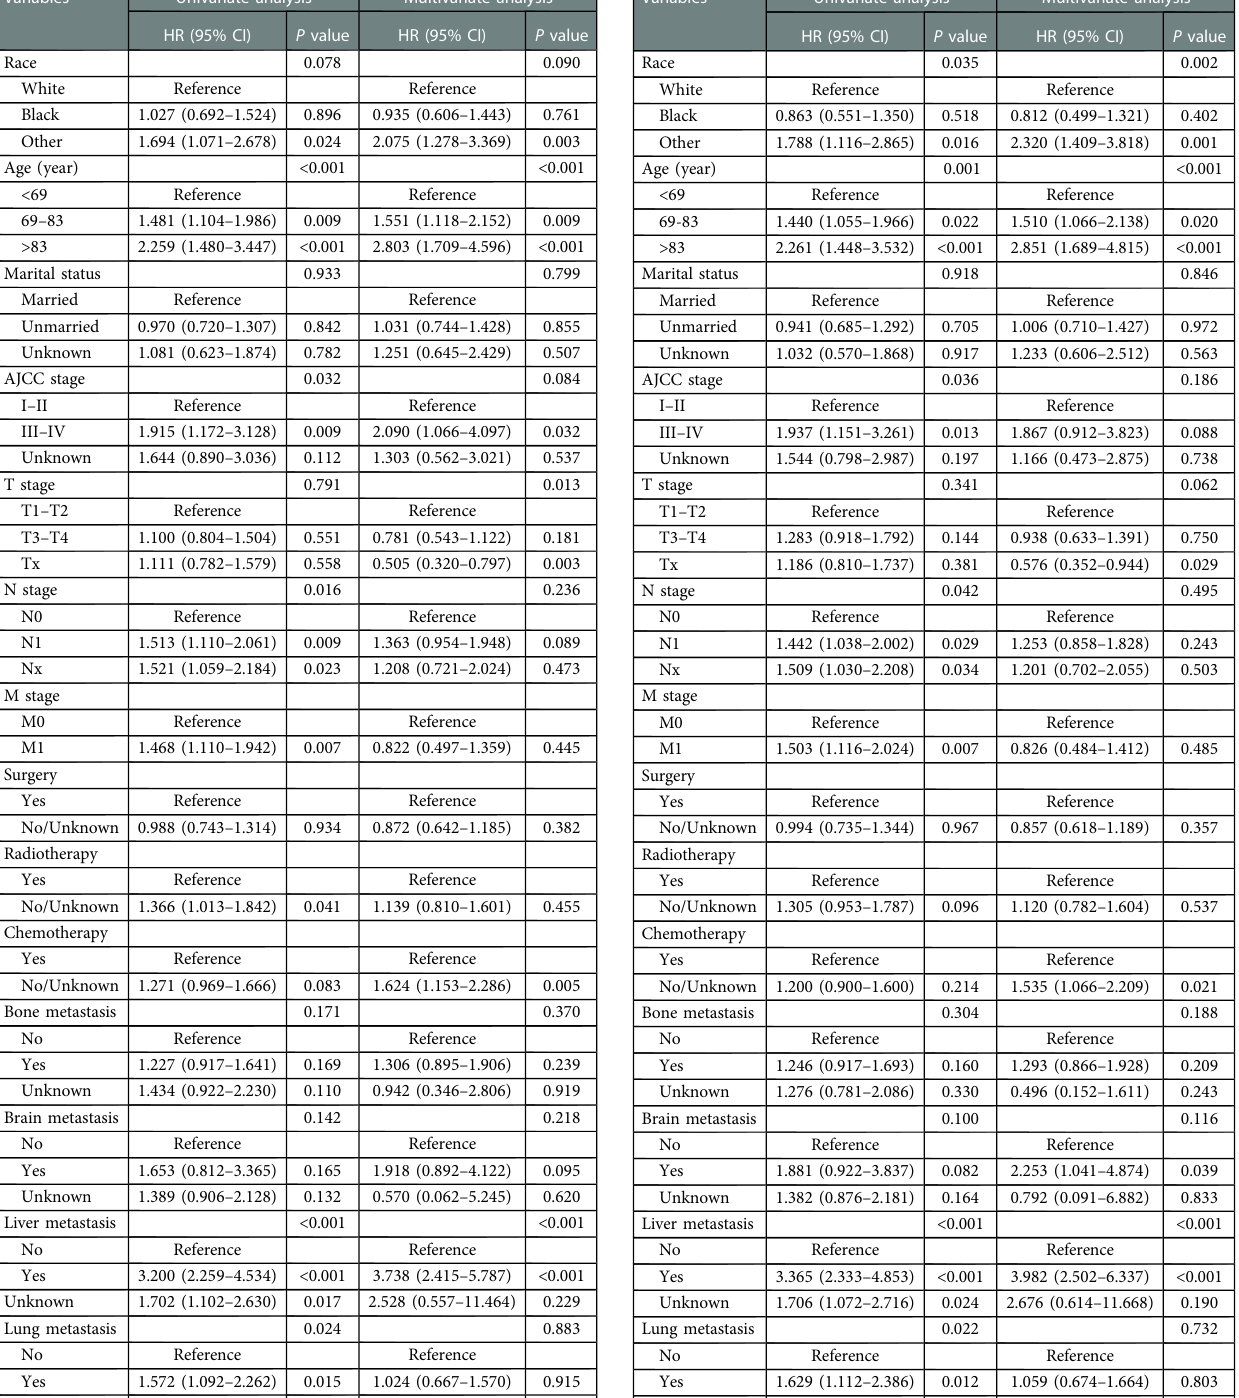
TABLE 2 Univariate and multivariate analyses of OS risk factors for NEPC. TABLE 3 Univariate and multivariate analyses of CSS risk factors for NEPC. Variables Univariate